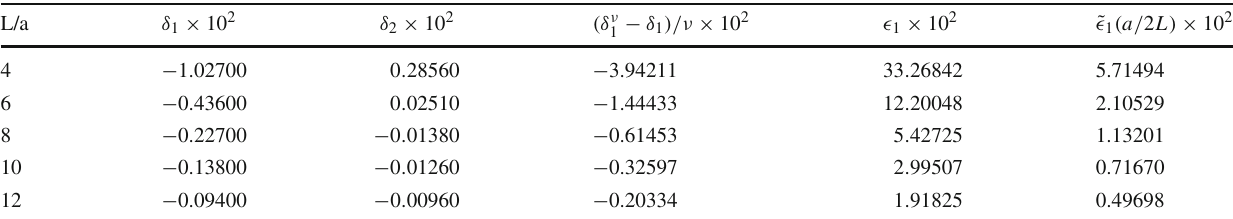
Table 2 Values of the coefficients for N f = 3 and the relevant lattice sizes, as required for perturbative cancellation of lattice artefacts up to 2-loop order in (cid:25) , and to one-loop order in (cid:25) ν , (cid:7) and ˜ (cid:7) , cf.